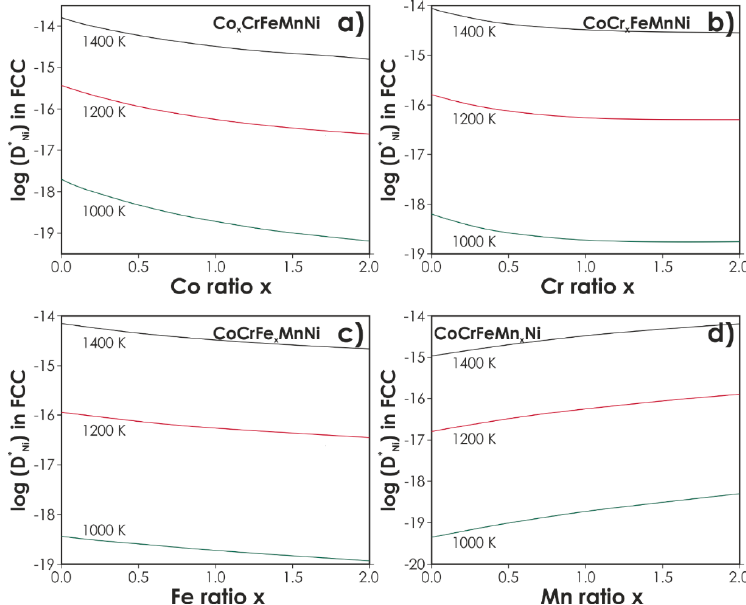
Figure 8. Calculated composition dependence of Ni tracer diffusivities in the Co-Cr-Fe-Mn-Ni system at different temperatures, for different content of considered elements ( x ) (after [34]). Reprinted by permission from Springer Nature: Springer, Journal of the Phase Equilibrium and Diffusion, Zhang, C.; Zhang, F.; Jin, K.; Bei, H.; Chen, S.; Cao, W.; Zhu, J.; Lv, D. Understanding of the Elemental Diffusion Behavior in Concentrated Solid Solution Alloys, 2017. As can be seen, in some cases, the concentration dependence of tracer diffusivities was a very strong one, with the differences between x = 0 and x = 2 compositions being as high as 1.5 orders of magnitude (e.g., in Co x CrFeMnNi). comprehensive approaches to the topic of diffusion studies in HEAs. Still, it should be remembered that all data used in this study, while based on the solid experimental foundation, was an extrapolation and, therefore, should be verified with further experimental results. The last article published in the mentioned special issue of the Journal of Phase Equilibria and Diffusion was authored by Chen et al. [35] and could be treated as the beginning of the longer series of articles by this team. The authors investigated interdiffusion in Co-Cr-Fe-Mn-Ni alloys using the diffusion multiples experiment (conducted at 1373 K), coupled with the so-called "pragmatic numerical inverse method" [73]. The applied theoretical description was based on Equations (1), (7) and (8) combined with Manning's formalisms. The "pragmatic numerical inverse method", while, in general, similar to the combinatorial approach developed earlier by Kucza [64], during the optimization, uses not only concentration profiles but also fluxes. Such an approach may offer some advantages in comparison to the one based strictly on the optimization of concentration profiles as it provides more information, enhancing the probability that as a result of the optimization process, the global minimum is reached. Still, the calculation of fluxes based on the experimental results is always affected by an error; therefore, the usefulness of such an approach is strictly correlated with the quality of the measured concentration profiles, as well as the quality of data processing. Also, another factor that may influence the obtained results is the applied weighting factors between the influence of the concentration profiles error and flux fitting error.